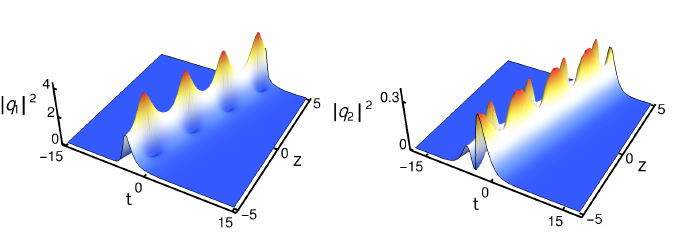
Figure 14. Breathing nondegenerate fundamental soliton in the GCNLS system. Here the parameters are k 1 = 1.65 + 0.5 i , l 1 = 0.45 + 0.5 i , α b = 0.5 − 0.5 i